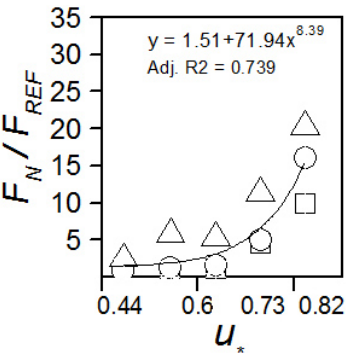
Figure 6. A statistically fitted relationship between dust emissions ratios and u ∗ for all livestock-trampled surfaces; n denotes sam- ple number; v is degree of freedom; χ/v is the reduced chi square; RMSE is root mean square error; Adj .R 2 is adjusted r 2 , residual sum of